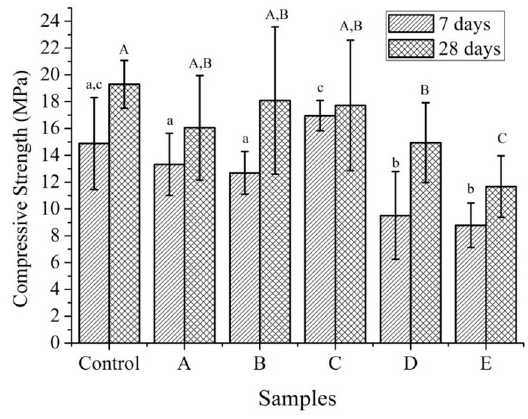
Figure 8. Results of the compressive strength of mortars obtained with different proportions of the residue, in the hardened state at 7 and 28